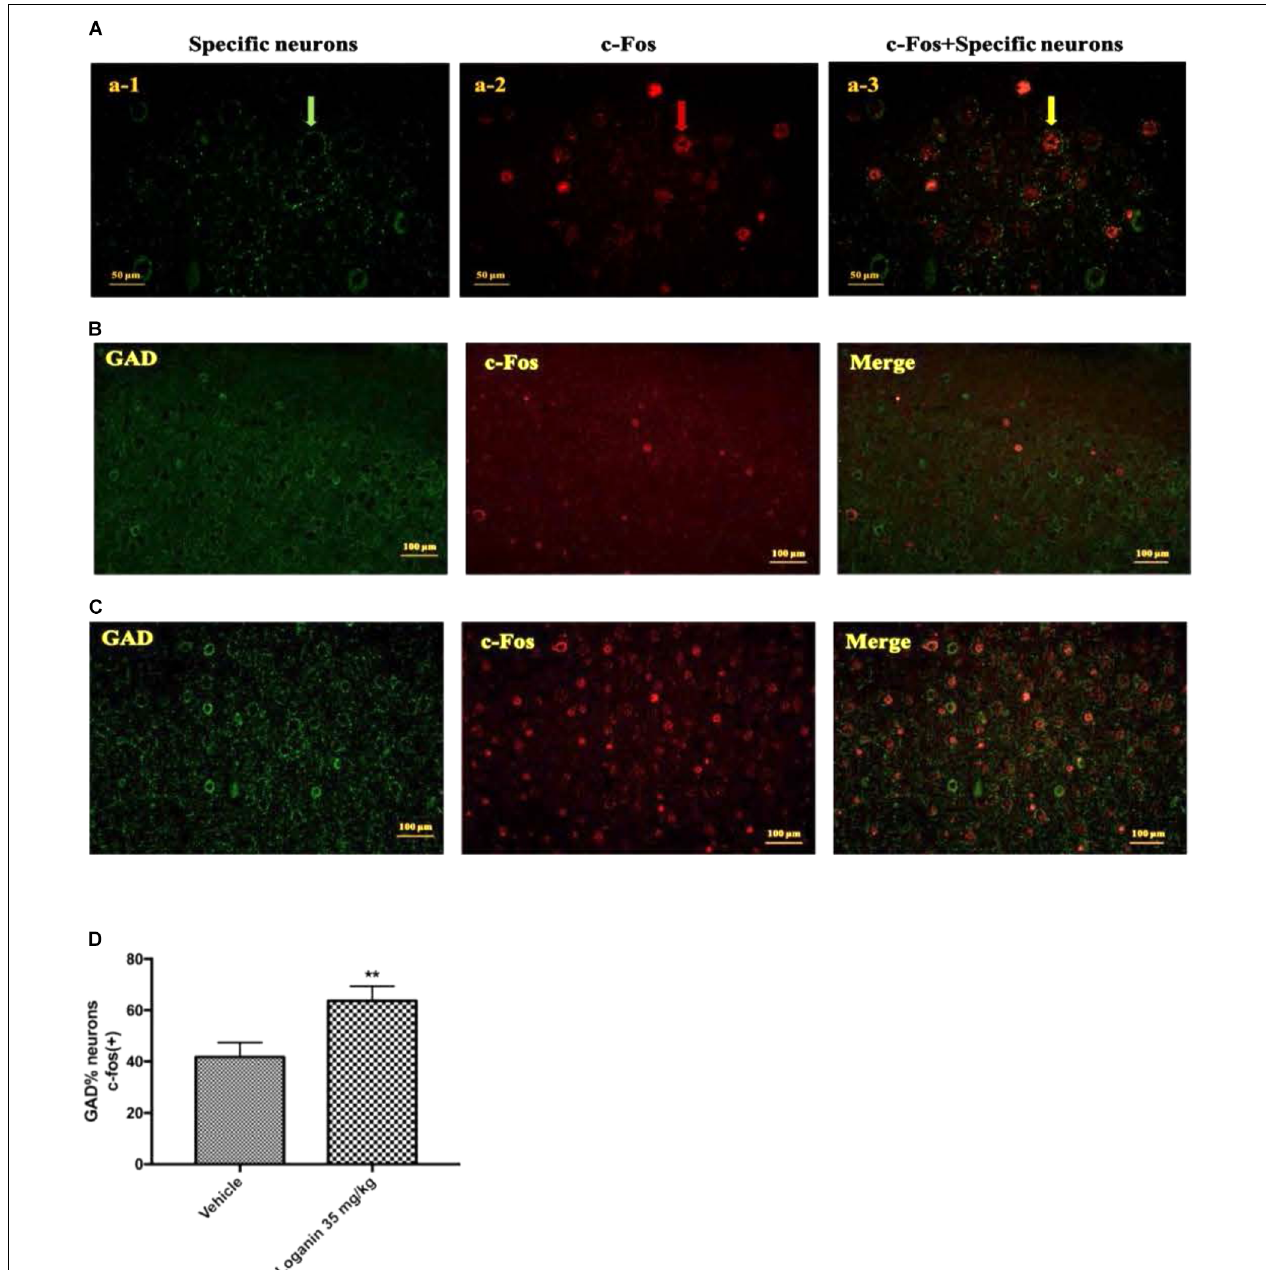
FIGURE 9 | The effect of Loganin on c-Fos expression in the VLPO. The GABAergic neurons were labeled by green, c-Fos was labeled by red. (A) An example of photomicrographs of the double-immunostained neurons (scale bar = 50 µ m; original magnification 400 × ). Fluorescence micrographs of c-Fos and GAD in normal mice (B) and mice treated with loganin 35 mg/kg (C) (scale bar = 100 µ m; original magnification 200 × ). (D) Quantification of the number of c-Fos positive GABAergic neurons. Data are represented as mean ± SEM ( n = 5). ∗∗ P < 0.01, vs. vehicle (unpaired Student’s t